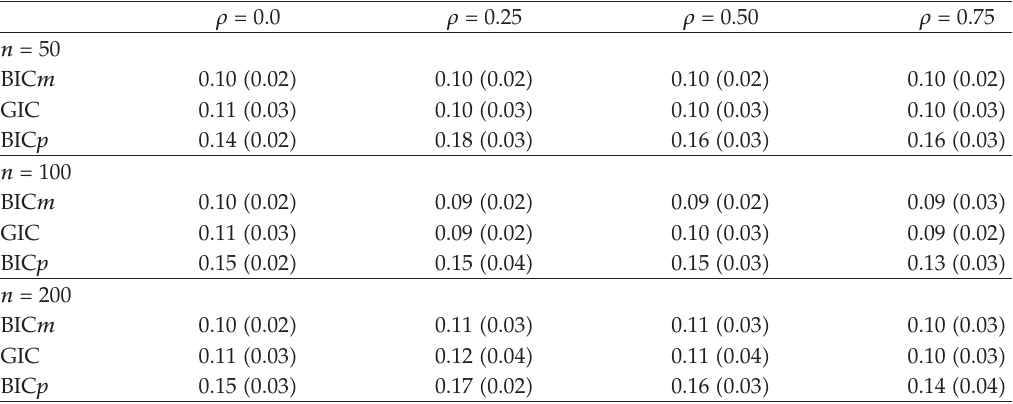
Table 5: Means (cid:3) standard deviations (cid:6) of the deviations of basis functions. ρ (cid:7) 0 . 0 ρ (cid:7) 0 .